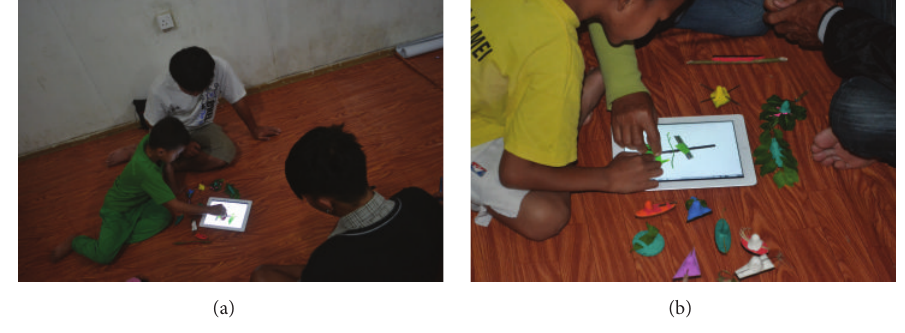
Figure 7: Users testing tangible system.